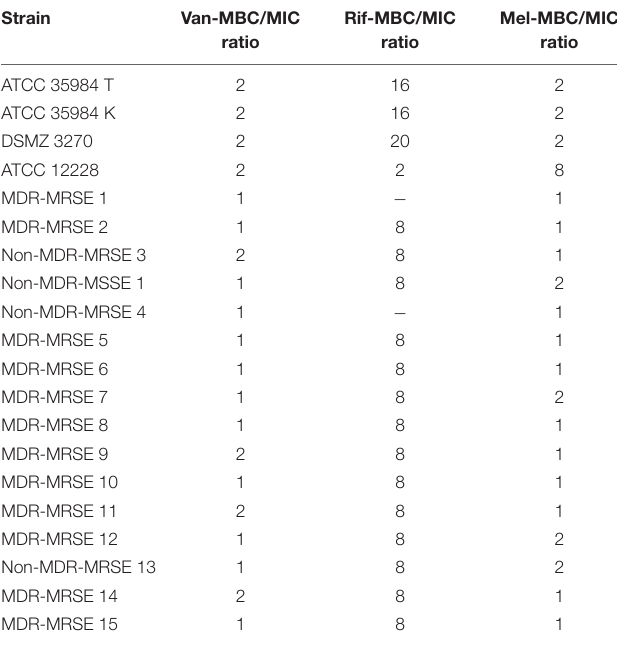
TABLE 2 | MBC/MIC ratios for vancomycin, rifampin, and melittin against Staphylococcus epidermidis. Strain Van-MBC/MIC